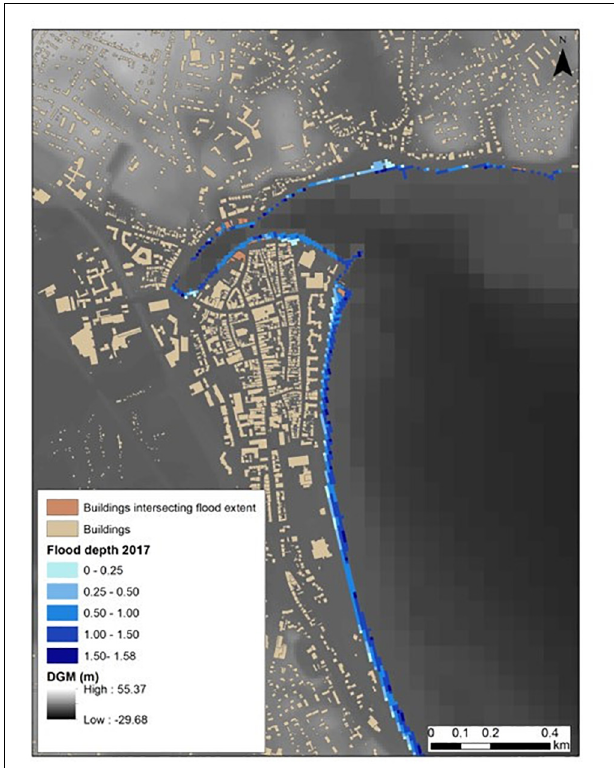
FIGURE 3 | Simulated flood extent for the January 2017 storm surge.